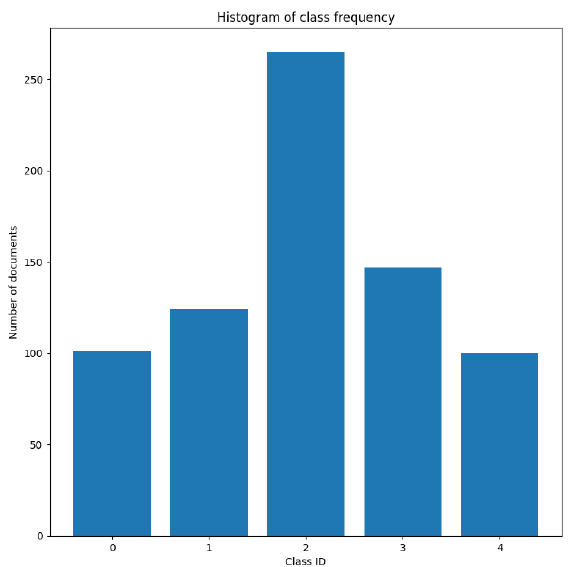
Figure 8. Class frequency distribution for BBCSport.